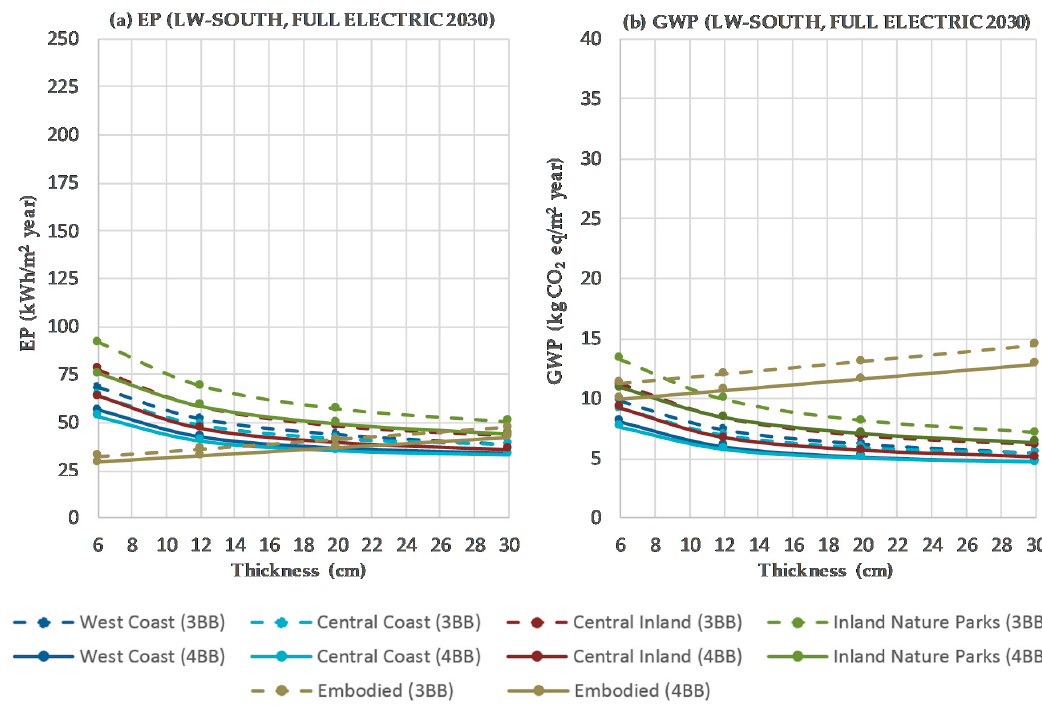
Figure 11. Embodied and use impacts of primary energy and CO 2 equivalent emissions for the electricity-only scenario in Spain’s 2030 horizon [23,46], depending on insulation thickness, for the four locations, with LW-SOUTH both for 4BB and 3BB.